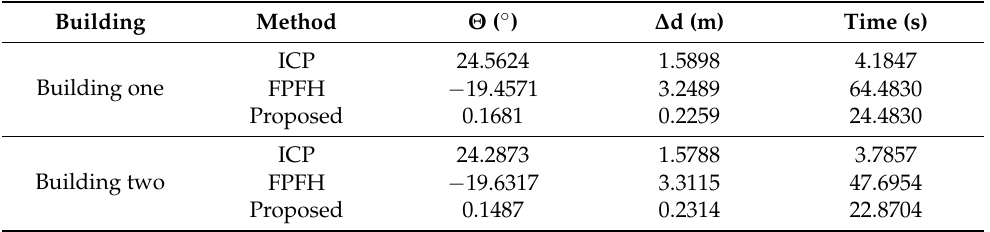
Table 3. Alignment accuracy parameters of Experiment 3. Processing times are obtained by a regular desktop PC (Intel